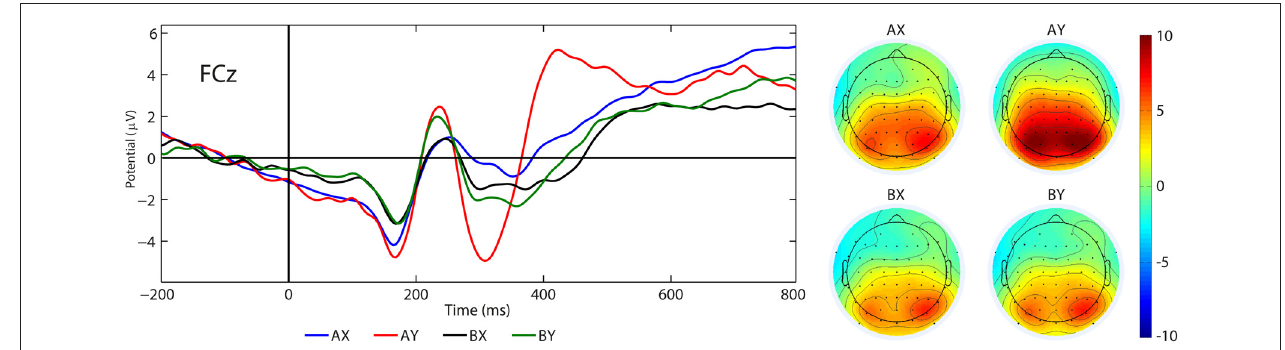
FIGURE 8 | Grand average ERPs (P3a) and topographical maps elicited by the AX, AY, BX and BY sequences at